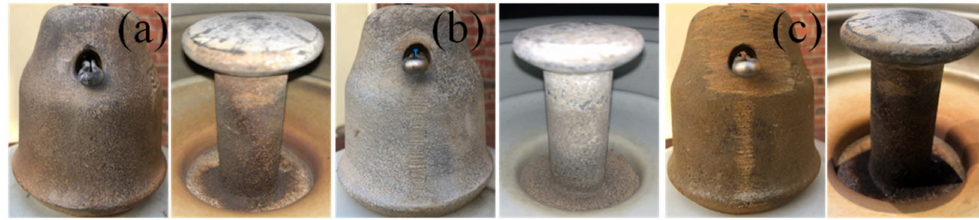
Figure 8. Pictures of pins and caps of porcelain insulators gathered from ( a ) Daejeon, ( b ) Ulsan, and ( c ) Busan. Each was used for 38